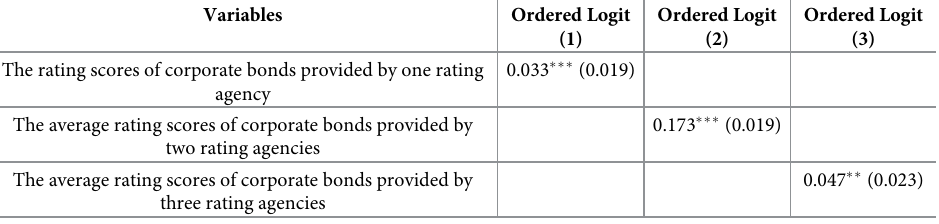
Table 11. Robust results of effort of rating